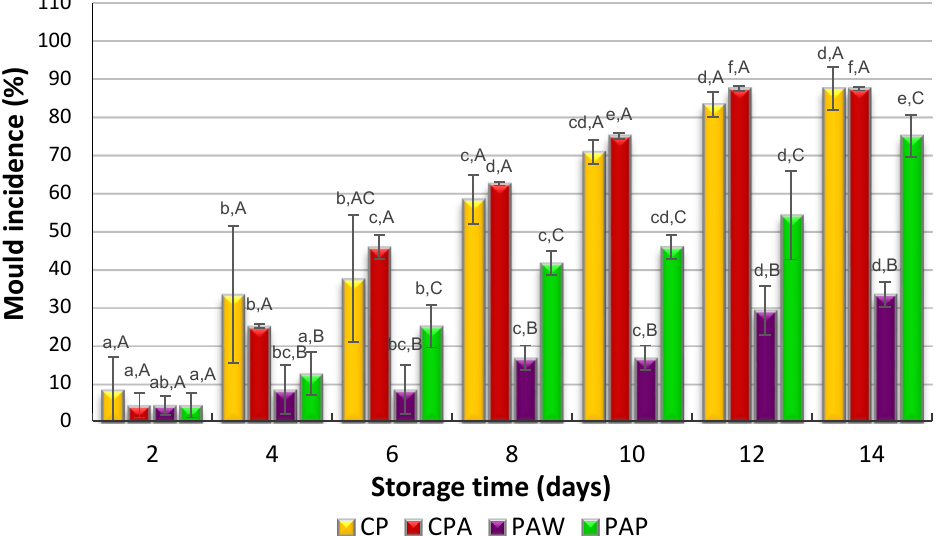
Figure 2. The effect of biofilms with W. anomalus or P. membranifaciens on the incidence of P. italicum on apple fruit. CP: fruit injured and inoculated with P. italicum ; CPA: fruit injured and inoculated with P. italicum , coated with alginate; PAW: fruit injured and inoculated with P. italicum , coated with alginate containing W. anomalus ; PAP: fruit injured and inoculated with P. italicum , coated with alginate containing P. membranifaciens . a–f: values with different superscript Roman letters (for each storage time) were significantly different ( p < 0.05); A–C: values with different superscript Roman letters (for each treatment) were significantly different ( p < 0.05).